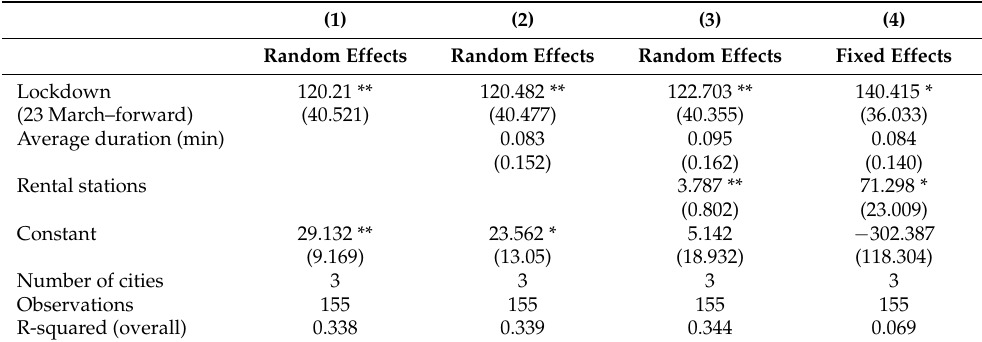
Table 9. The effect of lockdown on number of rides, comparing period before and after lockdown, excluding rides with duration less than 5